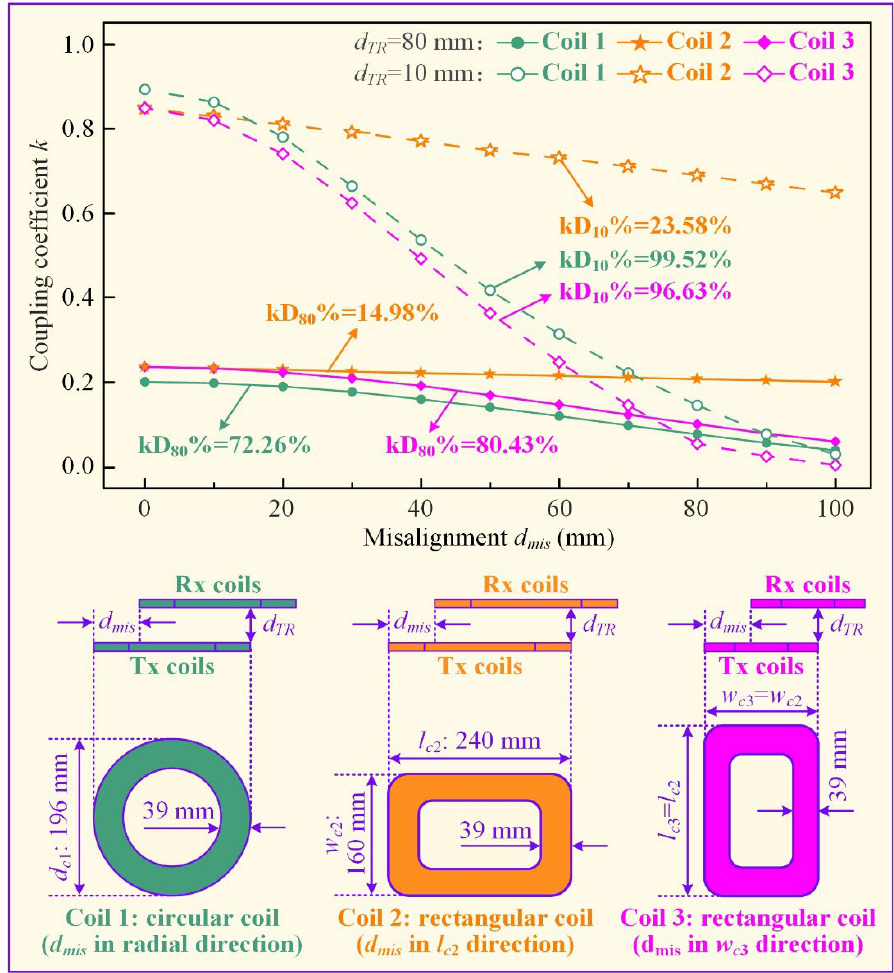
Figure 5. Comparison of coupling coefficient k versus horizontal misalignment with nominal and extremely small transmission distance, respectively.